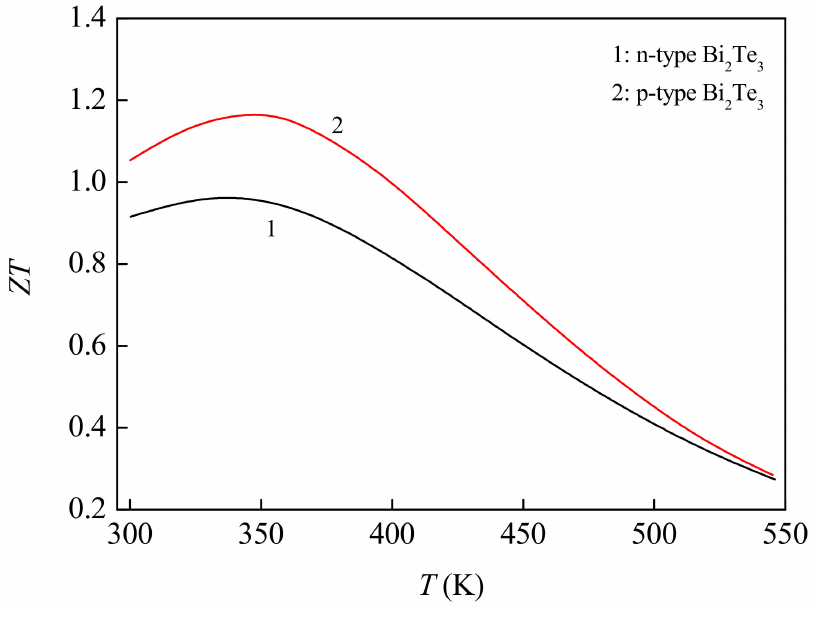
Figure 3. Figures of merit of Bi 2 Te 3 materials